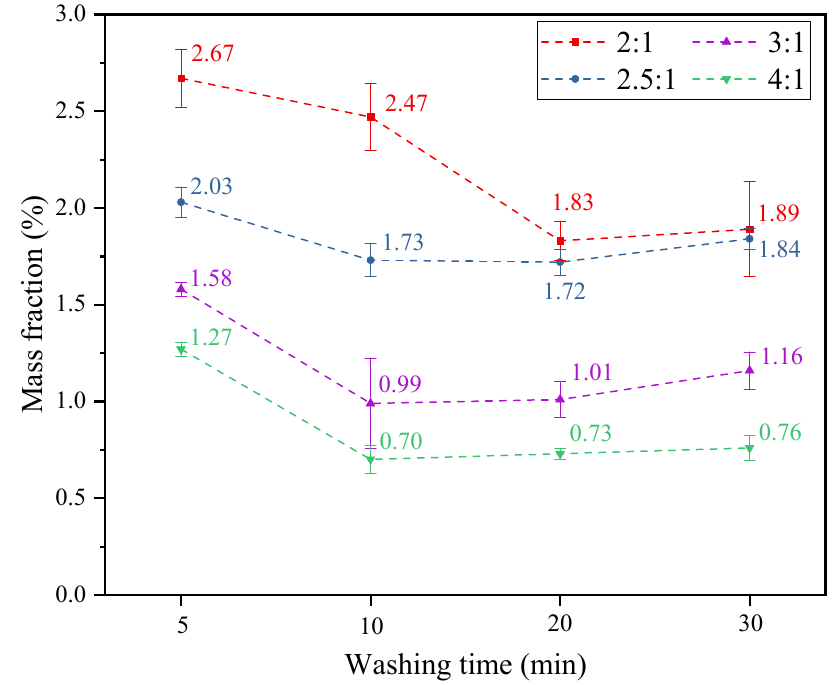
Figure 5. The mass fraction of soluble chlorine in washed fly ash. Y. Mao et al. [34] compared single, double, and triple water-washing processes and found that when LSR = 3 L/kg, the chlorine content was reduced from 9.4% to around 2.4%, 0.9%, and 0.6% in the three processes, respectively. As estimated based on the mass loss of 20%, the dechlorination effect was around 80%, 93%, and 95%, respectively. Compared with TSC washing, washing twice or three times did not show obvious advantages, but produced two- or three-times the volume of WWS. Y. Wang [42] studied the dechlorination effect of two-stage and TSC water-washing processes, and when LSR = 3 L/kg, the mass percentage of chlorine in fly ash was reduced to 20% and 8.1% in the two processes, respectively, and the dechlorination effect was around 87% and 95%, respectively. This reveals that two-stage counter-current water washing did not show a great dechlorination effect when LSR = 3 L/kg, and TSC water washing is the suggested dechlorination method for high chlorine waste incineration fly